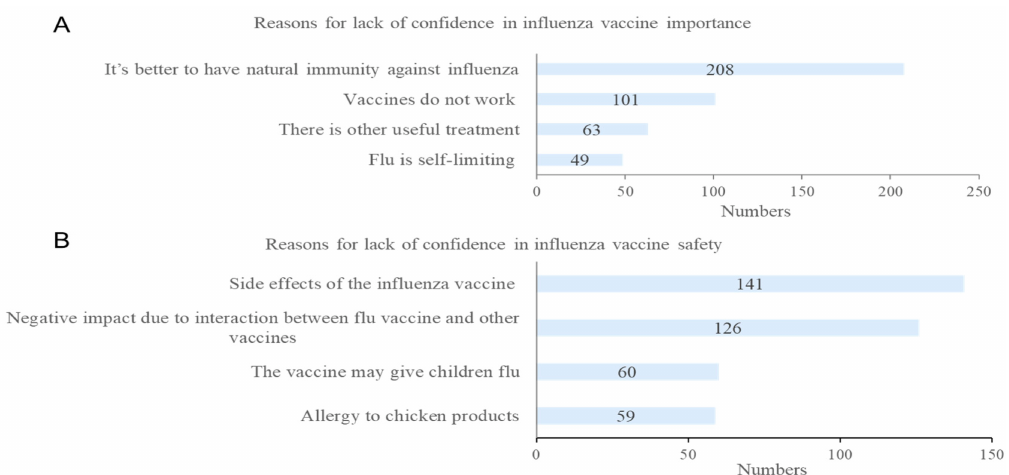
Figure 3. Caregivers’ reasons for lacking vaccine confidence: ( A ) Reasons for lack of confidence in influenza vaccine importance; ( B ) Reasons for lack of confidence in influenza vaccine